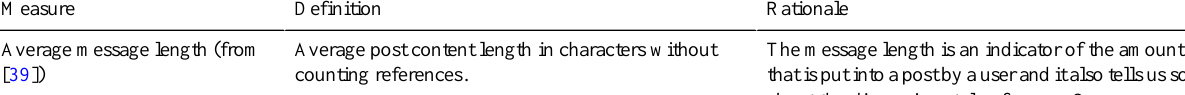
Table 2. Definition of behavior